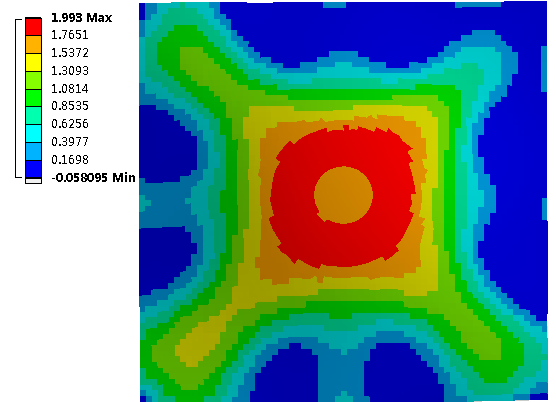
Figure 10. Relationship between force and time.